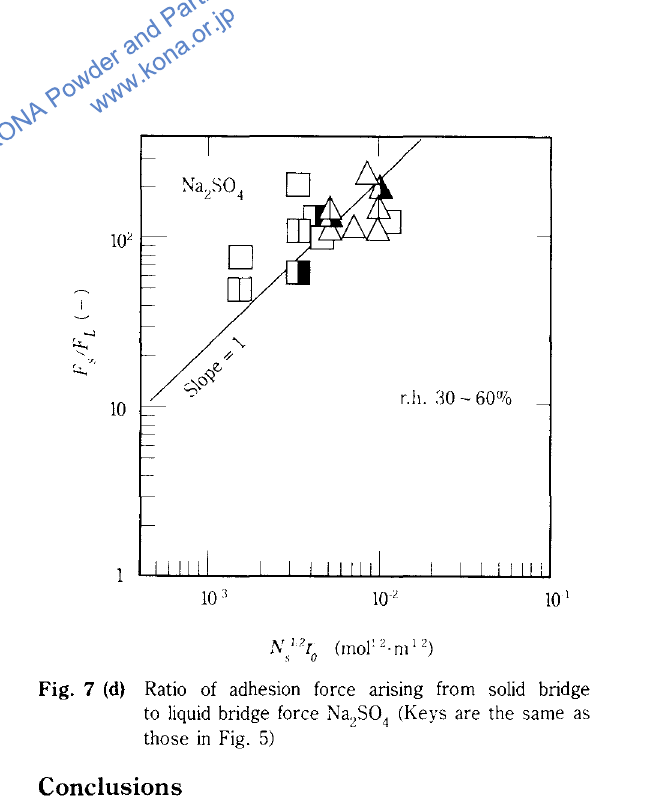
S0 (Keys are the same as 2 4